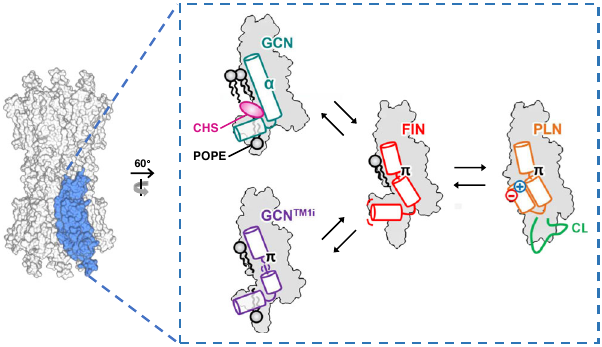
Fig. 8 | Schematic diagram of a dynamic conformational equilibrium of Cx43 GJICh in POPE-nanodiscs with a low CHS content. The structural change in only one protomer is depicted. POPE and CHS are colored in black and pink, respec- tively, and labeled. In the middle of TM1, α - and π -helices are indicated as α and π , respectively. The green line in the PLN protomer indicates partial stabilization of